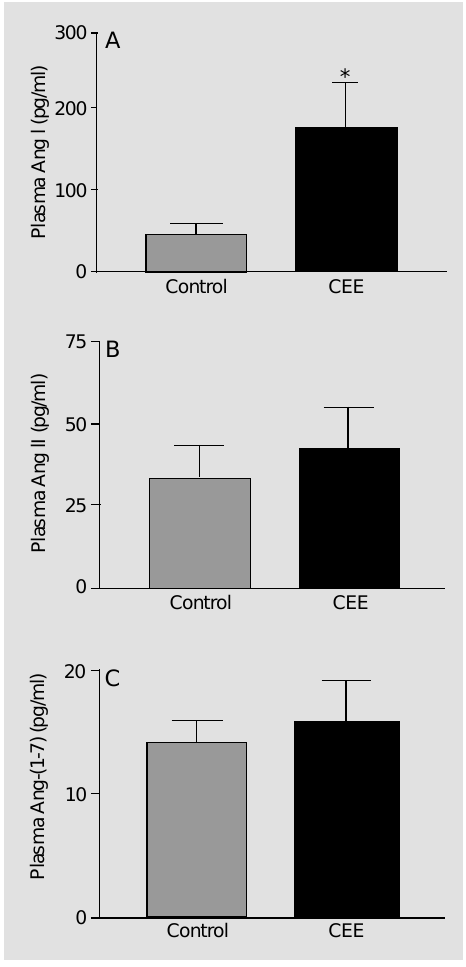
Figure 2 - Effects of estrogen on plasma Ang I (A), Ang II (B), and Ang-(1-7) (C). Values are re- ported as mean ± SEM. *P<0.05 vs control (Student t -test). All cy- nomolgus monkeys were ovari- ectomized and left either un- treated (control) or treated with conjugated equine estrogens (CEE). (Reproduced from Ref. 72 with permission